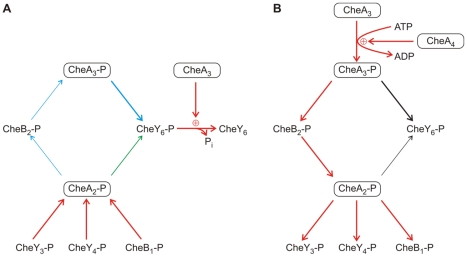
Summary of the phosphate-sink and phosphorelay pathways.(A) The phosphotransfer reactions that allow CheY6 to work as a phosphate-sink for the other RR-Ps. CheY3-P, CheY4-P, CheB1-P can act as phosphodonors for CheA2. Phosphoryl groups can take either of two routes from CheA2 to the CheY6-phosphate-sink. CheA2-P can directly phosphorylate CheY6 (shown in green) or alternatively, can phosphorylate CheB2, which can transfer the phosphoryl group to CheA3 which then phosphorylates CheY6 (shown in blue). CheY6-P is rapidly dephosphorylated due to the specific phosphatase activity of the bifunctional enzyme CheA3. For diagrammatic simplicity, reversible reactions are shown as operating in the direction that leads towards the sink. (B) Diagram summarizing the role of CheB2 and CheA2 in relaying phosphoryl groups from CheA3-P to its non-cognate RRs, CheY3, CheY4 and CheB1. The reactions necessary for this phosphorelay are highlighted in red. At the cytoplasmic chemotaxis cluster, phosphoryl groups are transferred from CheA3-P to CheY6 and CheB2. CheB2-P then diffuses to the polar chemotaxis cluster where it serves as a phosphodonor for CheA2. CheA2-P subsequently acts as a phosphodonor for CheY3, CheY4 and CheB1. For diagrammatic simplicity, reactions which are reversible are shown as operating in the direction that leads towards the non-cognate RRs of CheA3.